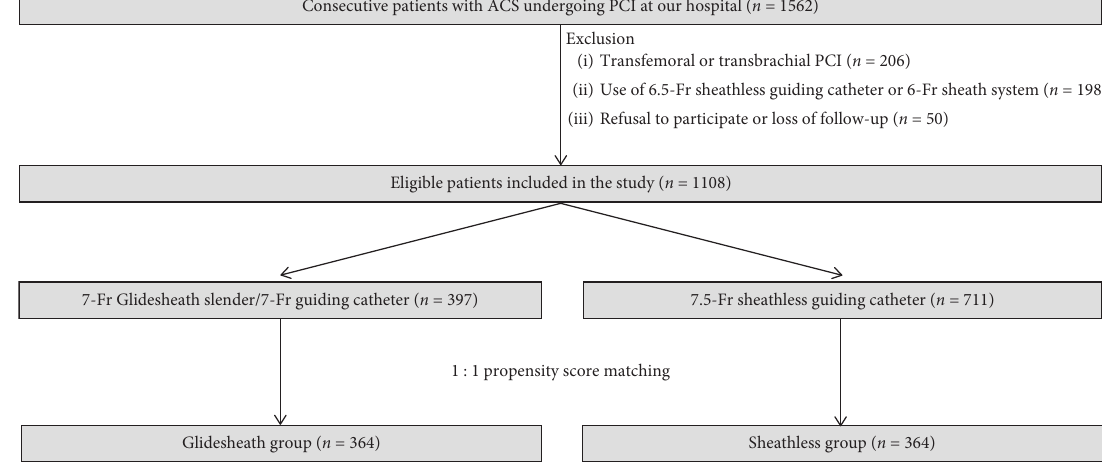
Figure 2: Flowchart of study design and patient selection criteria. ACS, acute coronary syndrome; PCI, percutaneous coronary